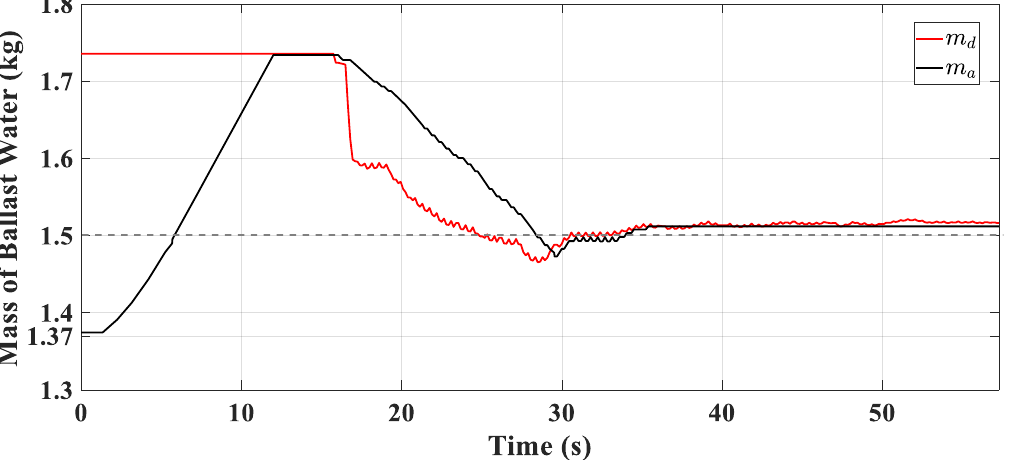
Figure 17. Ballast mass tracking error of depth control via on-off type VBS. Figure 18. Forward velocity response at the stage of fins control.